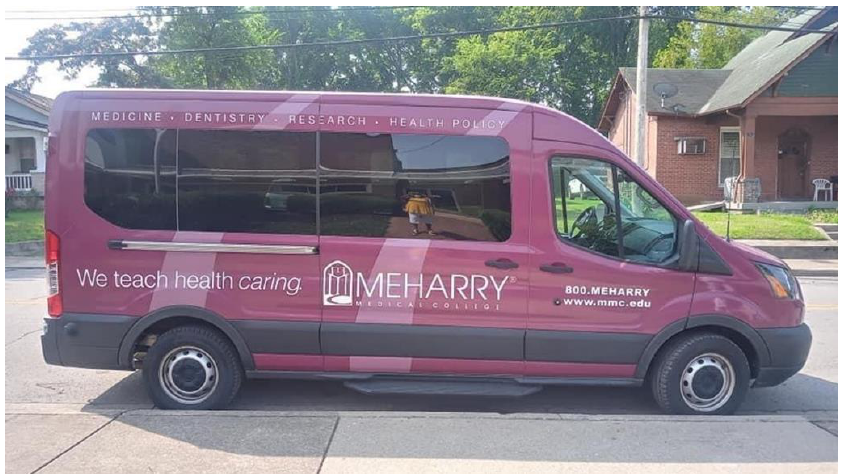
Figure 1. Meharry’s Mobile vaccine unit vehicle deployed to deliver COVID-19 vaccines throughout Middle Tennessee.